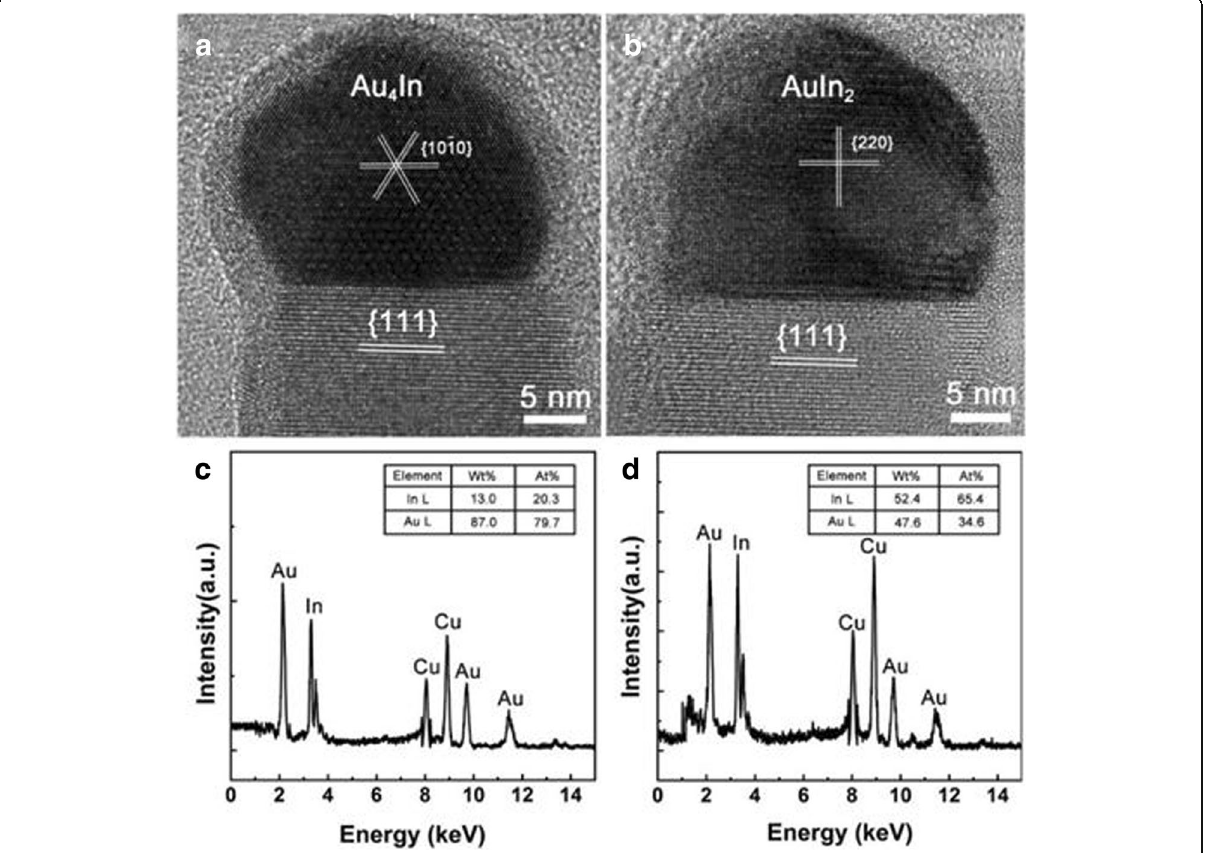
Fig. 6 HRTEM images of the Au nanoparticles with two kinds of structures, a Au 4 In and b AuIn 2 . c , d EDS of the Au nanoparticles in a and b ,